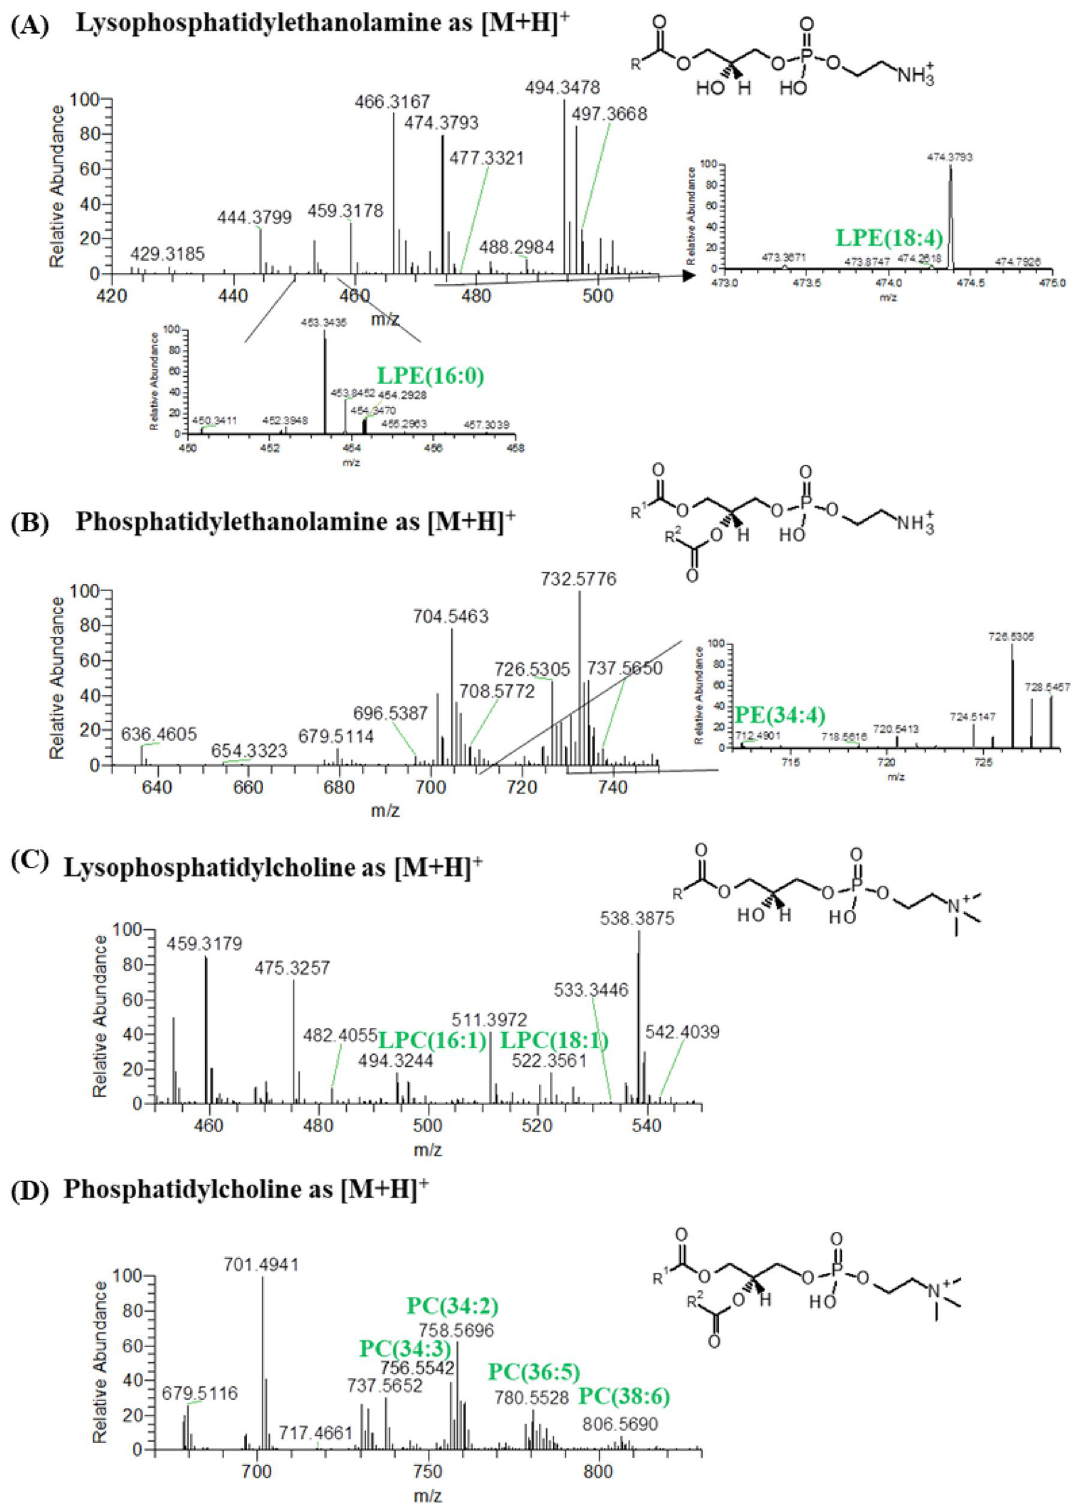
Figure 1. HILIC–HR–ESI–MS spectra of the classes of phospholipids (PL) identified in positive ion mode as [M+H] + . These classes were ( A ) lysophosphatidylethanolamine (LPE), ( B ) phosphatidylethanolamine (PE), ( C ) lysophosphatidylcholine (LPC) and ( D ) phosphatidylcholine